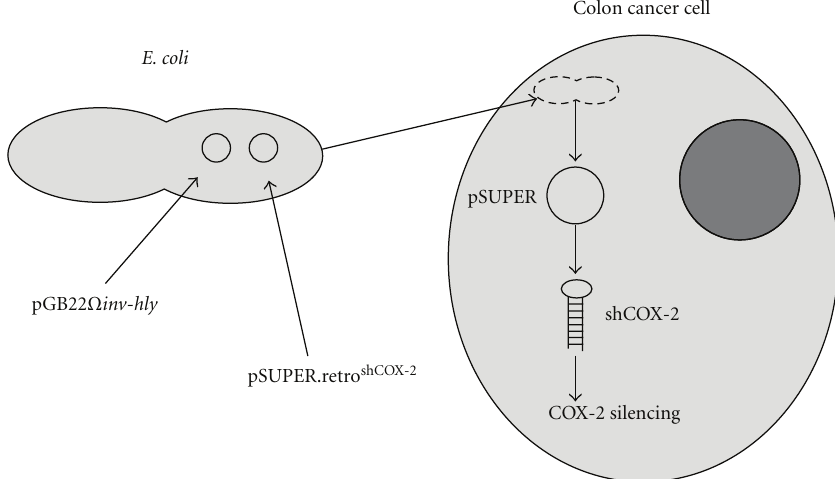
Figure 1: COX-2 silencing mediated by transkingdom RNAi. The cotransformation of E. coli with both plasmids pGB2 Ω inv-hly and pSUPER.retro shCOX-2 enables bacteria to induce the transkingdom RNAi phenomenon in colon cancer cells. Following the expression of the bacterial proteins invasin and listeriolysin-O, engineered E. coli strains are able to permeate human cells and release the plasmid DNA content. Anti-COX-2 shRNAs are then transcribed by the cellular machinery, resulting in an e ffi cient COX-2 silencing.